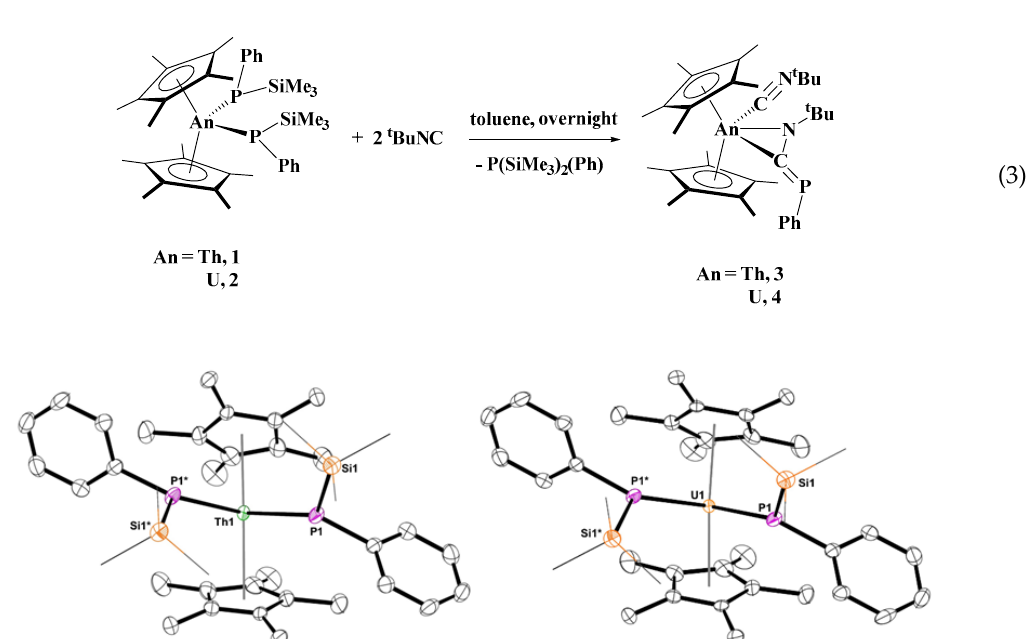
Figure 1. Thermal ellipsoid plots of 1 (left) and 2 (right) shown at the 50% probability level. Hydrogen atoms have been omitted and silyl groups shown in wireframe for clarity.